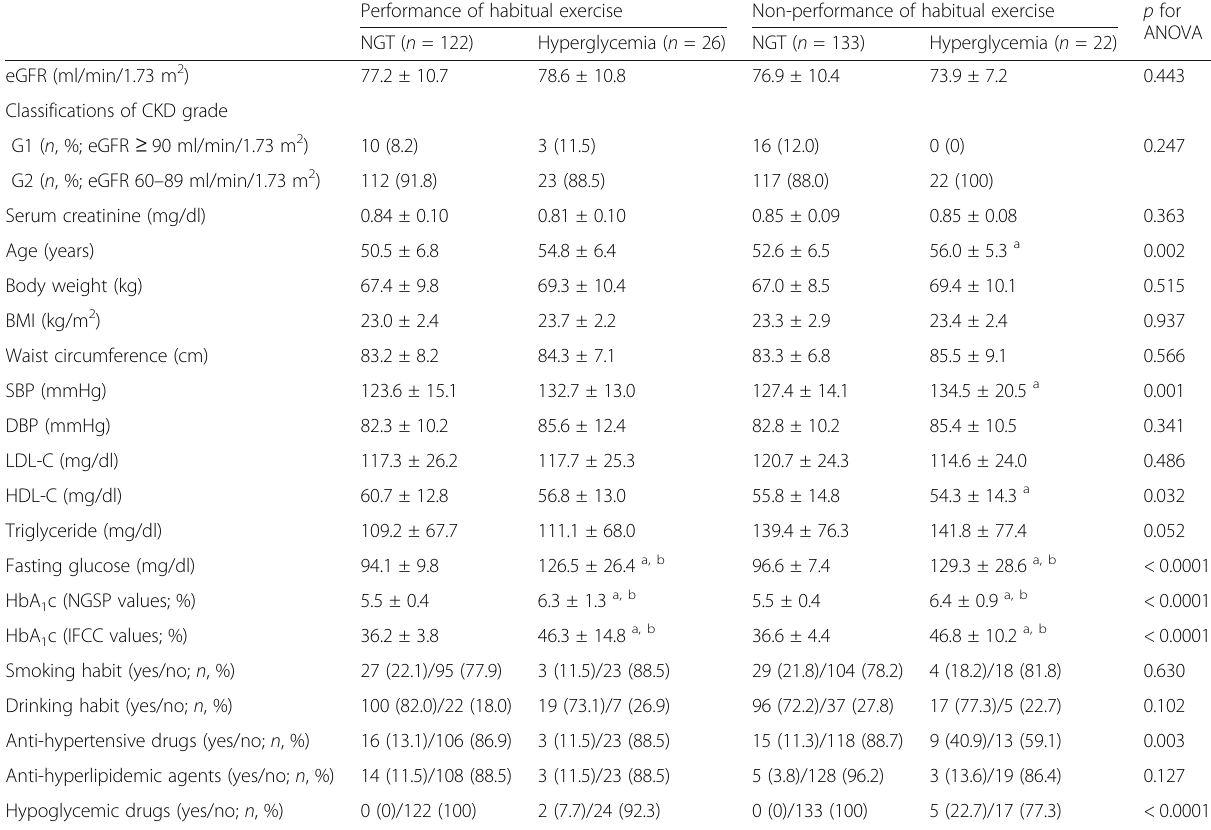
Table 3 The baseline characteristics in subjects according to the combination of habitual exercise (performance/non-performance) and hyperglycemia (presence/absence) Performance of habitual exercise Non-performance of habitual